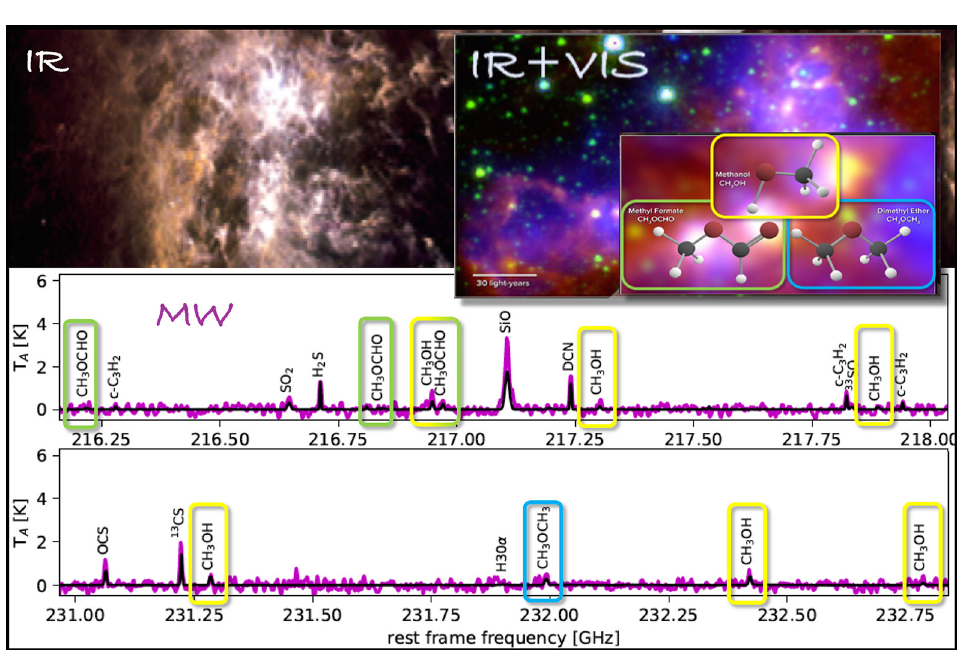
Fig. 1. – The Large Magellanic Cloud observed in different regions of the electromagnetic spec- trum. In the top panel, the far-infrared image shows a portion of the galaxy, with the zoom-in images on the right being a combination of mid-infrared data from Spitzer and visible (H-alpha) data from the Blanco 4-meter telescope. In the bottom panel, two Band 6 spectral windows of ALMA are shown: the rotational spectroscopic fingerprints of methanol, dimethyl ether, and methyl formate observed are highlighted